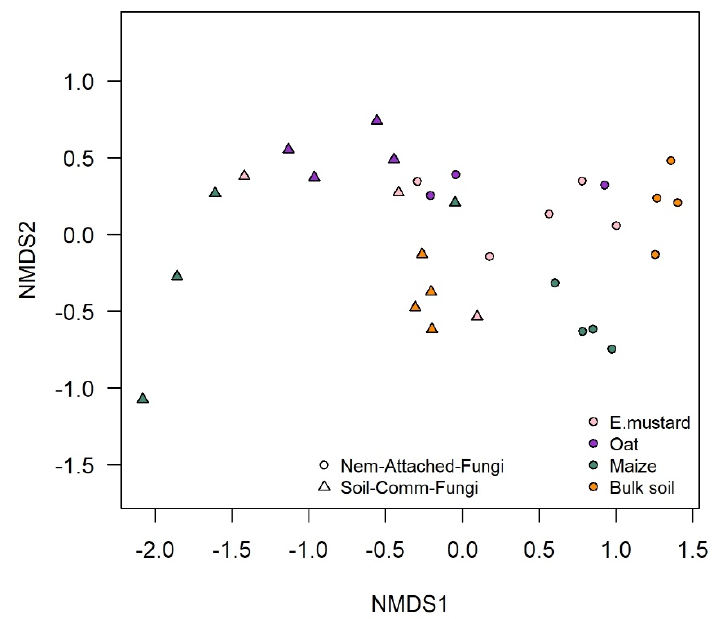
Figure 2. Effect of plant species on soil and P. penetrans attached fungi. Non-metric multidimen- sional scaling (NMDS) plots are presented based on Pearson correlations of background-sub- tracted densitometric curves from denaturing gradient gelelectrophoresis ( DGGE). Stress value is 0.031, n = 4.